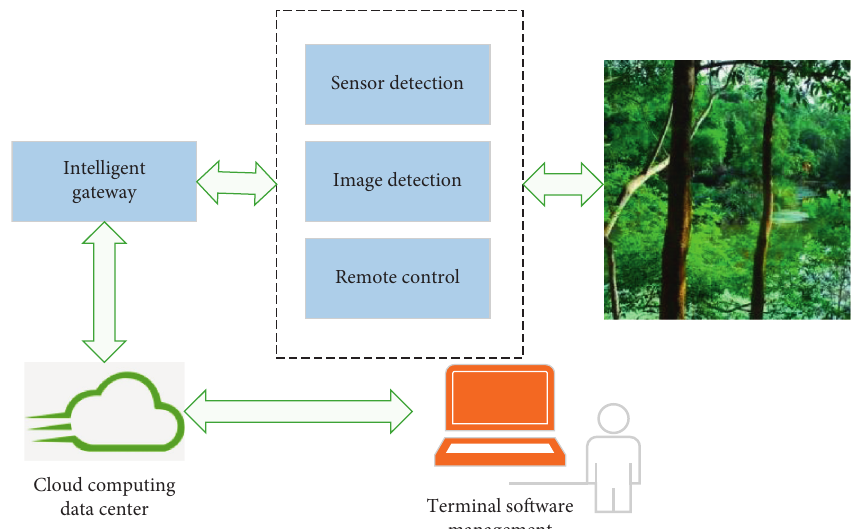
Figure 3: Smart garden management platform.